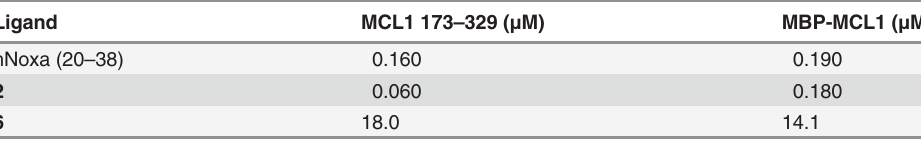
Table 1. Binding affinity (K D ) of ligands to MCL1 and MBP-MCL1.